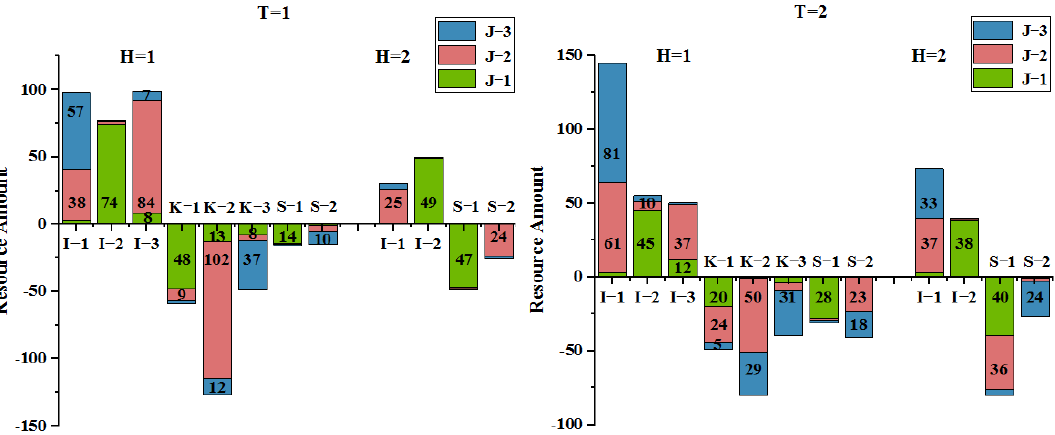
Figure 10. The resource flows of optimal rescue